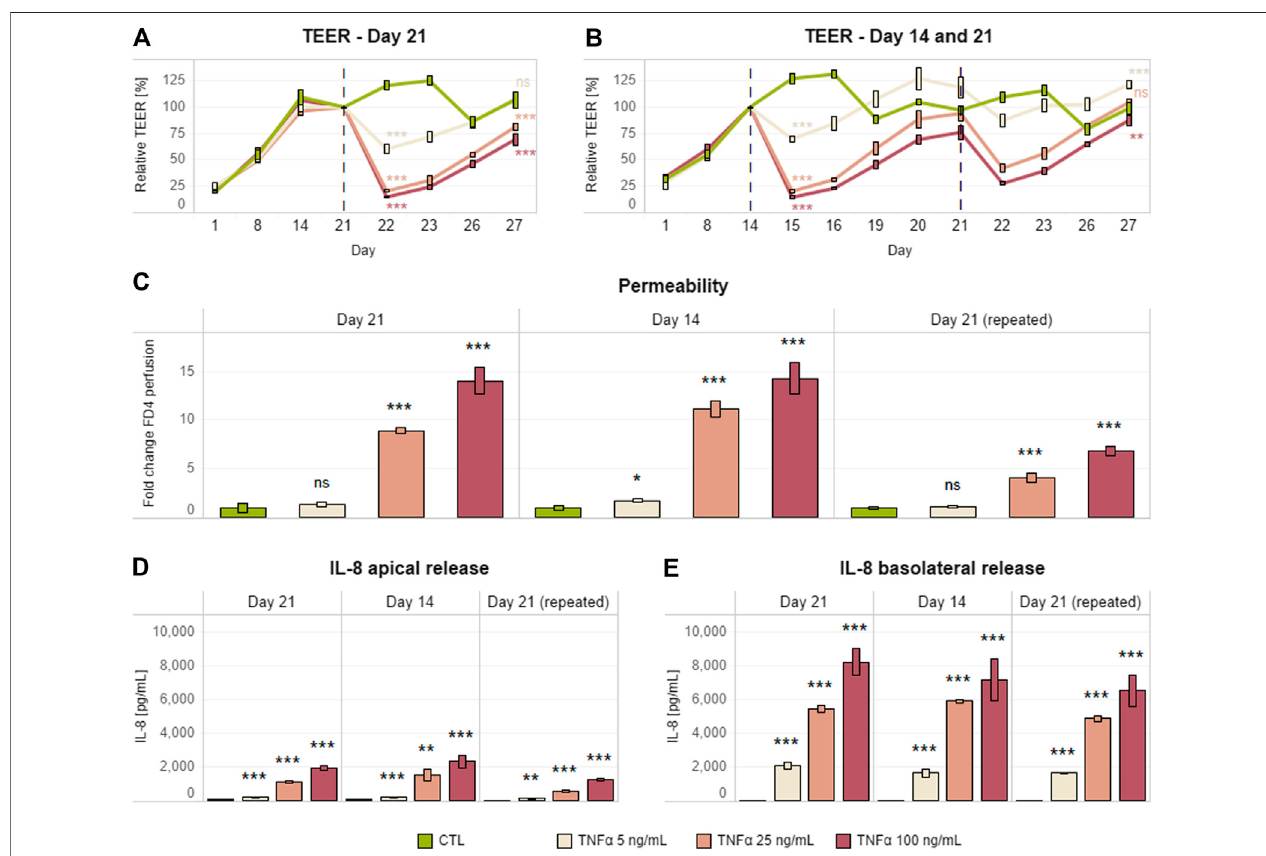
FIGURE 1 | Single and repeated Caco-2/HT29-MTX pro-in fl ammatory induction after days 14 and 21. TEER (A,B) , permeability (C) , and IL-8 release (D,F) in a differentiated Caco-2/HT29-MTX coculture basolaterally treated with different concentrations of TNF α (0 – 100 ng/ml) on day 21 (single) or days 14 and 21 (repeated). Each in fl ammatory stimulus (red dashed line) was left for up to 24 h; this was followed by arecovery period ofup to 120 h without an in fl ammatoryinducer. TEER values arerepresentedinpercentage;zero-hourtreatmentwasusedasreference(100%).Permeabilityisexpressedasfoldchangeovertheuntreatedcontrol(CTL).Data are presented as the average of three technical replicates with the corresponding standard deviations ( n (cid:2) 1; m > 3). On the day at the end of the simulation and the last day recorded, statistical differences between the control without TNF α and each of the three concentrations of TNF α were determined by a two-tailed t -test, * p ≤ 0.05; ** p ≤ 0.01;*** p ≤ 0.001;ns, p > 0.05.Equivalencecomparisonsandlinearregressionanalysisareprovidedin SupplementaryTablesS1andS2 .Abbreviations:TEER, transepithelial electrical resistance; TNF, tumor necrosis factor; CTL,